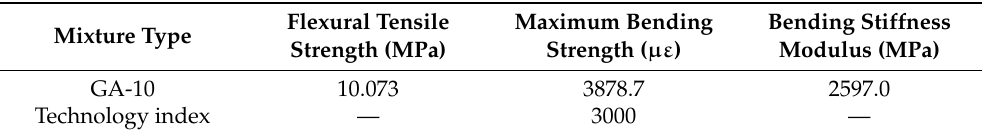
Table 11. GA-10 mix design inspection.